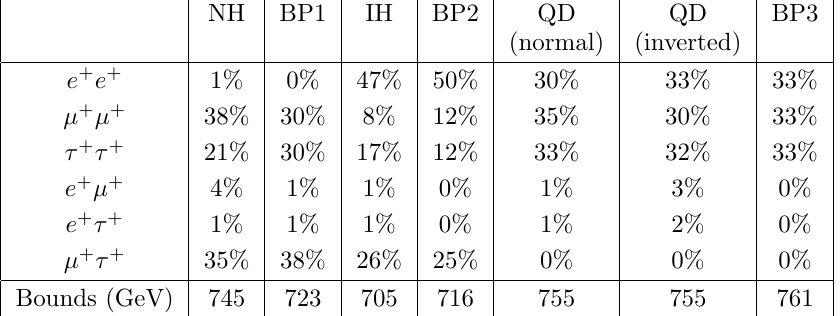
Table 5 . The columns NH, IH and the two QD are the branching ratios of H ++ for v These values also hold for v charged Higgs decays mainly into W BP2 and BP3 are the benchmark points in the CMS analysis [19].